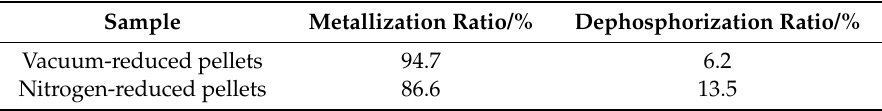
Figure 9. The macroscopic morphology changes of the pellets reduction process at different times under nitrogen condition.